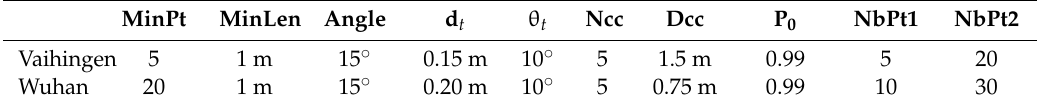
Table 2. Parameters used in the